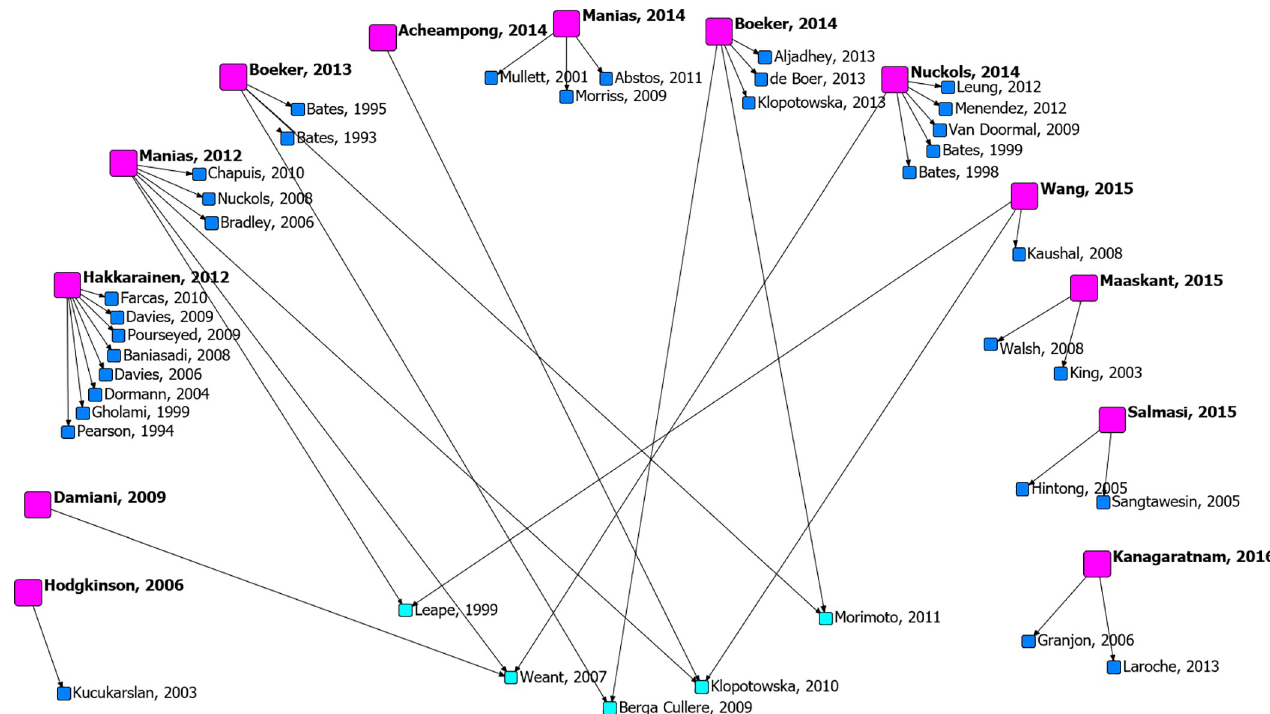
Fig 2. Citation network diagram of included systematic reviews with included primary studies that reported PADR data. Pink = systematic review; dark blue = primary study reported in only one systematic review; light blue = primary study reported in two or more systematic reviews.